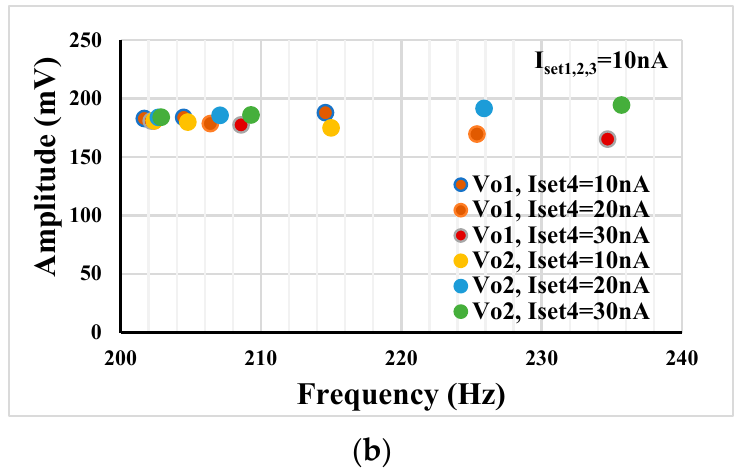
Figure 10. The amplitudes of V o1 and V o2 versus the oscillation frequencies ( a ) varying by R 1 , and ( b ) varying by g m 4 via I set4 .